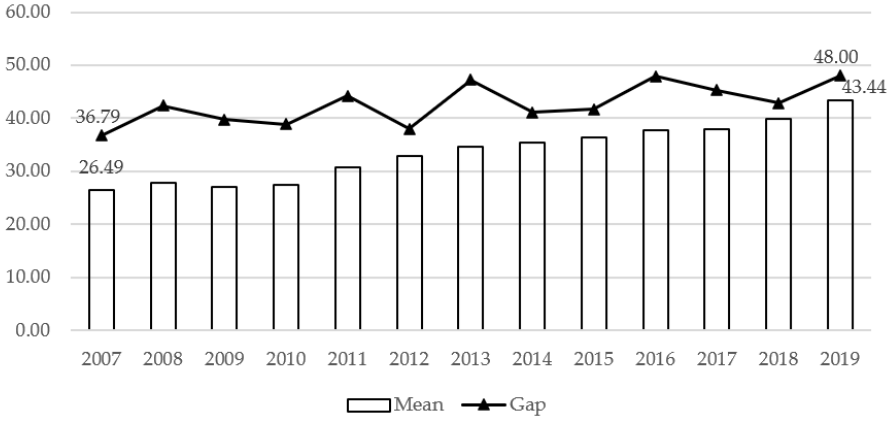
Figure 2. EEI of each region from 2007 to 2019. Note: The above figure is the estimated data, and the original data comes from the China Statistical Yearbook over the years.